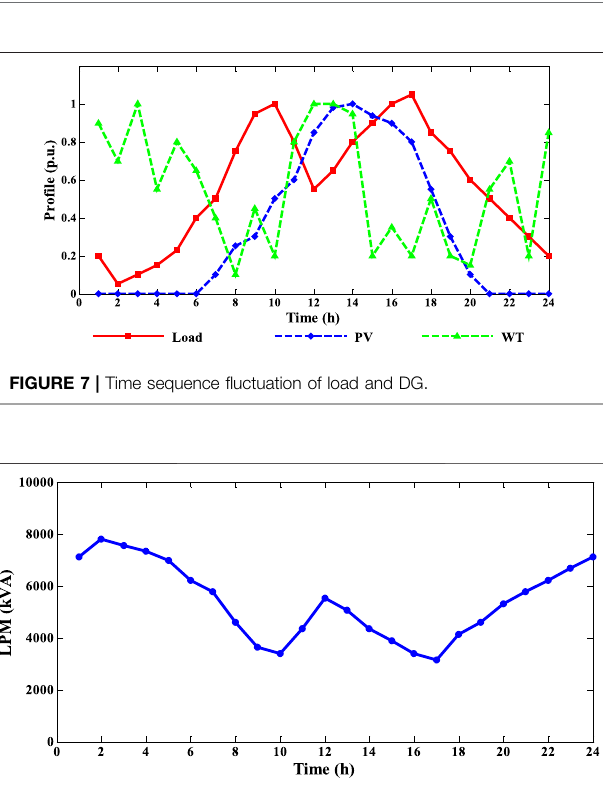
FIGURE 8 | Time sequence fl uctuation of LPM.